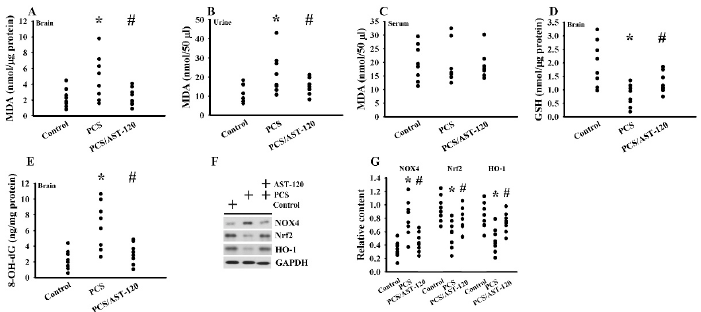
Figure 7. PCS induced oxidative stress. Unilateral nephrectomized mice were intraperitoneally injected with PCS (0, Control; and 100 mg/kg, PCS) and the PCS-injected mice were orally given with AST-120 (400 mg/kg, PCS/AST-120) for 7 weeks. The prefrontal cortical tissues ( A ), urine ( B , 24 h), and blood ( C ) were collected and subjected to the measurement of MDA levels. The prefrontal cortical tissues were collected and subjected to the measurement of GSH content ( D ). The prefrontal cortical tissues were collected and subjected to the measurement of 8-OH-dG content ( E ). Proteins were extracted from the isolated prefrontal cortical tissues and subjected to a Western blot test with the indicated antibodies. Representative blots ( F ) and the quantitative data ( G ) are shown. * p < 0.05 vs. control group and # p < 0.05 vs. PCS group, n = 8.